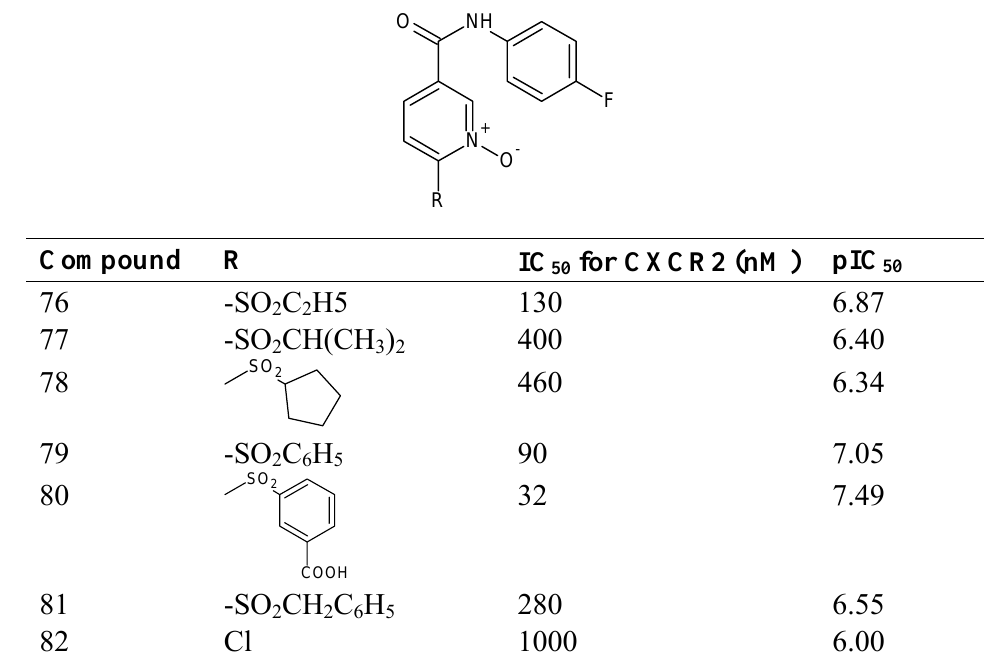
Table 5. Structures and biological activities of the triazolethiol